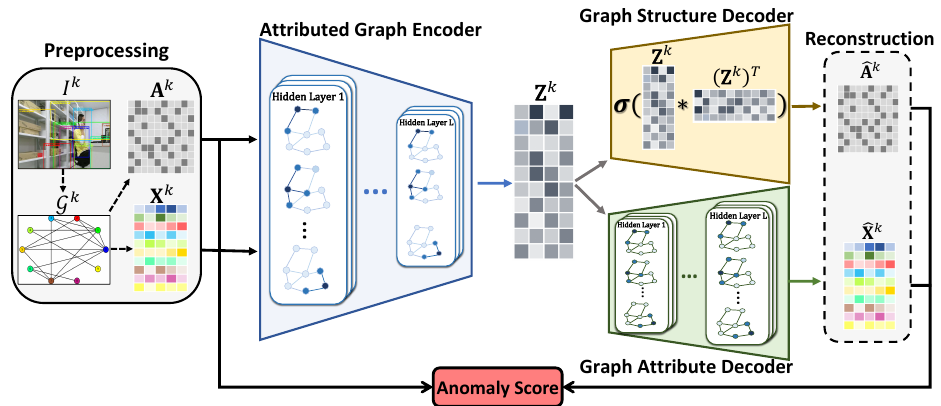
Figure 2. Whole architecture of the proposed method.